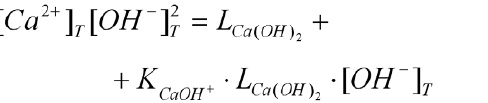
Figure 3. The product [Ca 2+ ] [OH – ] T2 as a function of the [OH – ] T T in Na(Cl,OH) mixtures with constant ionic strength (1.0 M) and at 25.00 ± 0.02 o C, where [Ca 2+ ] is the equilibrium T concentration of Ca 2+ in an aqueous solution saturated with solid Ca(OH) and [OH – ] is the total analytical 2 T concentration of hydroxide ions.